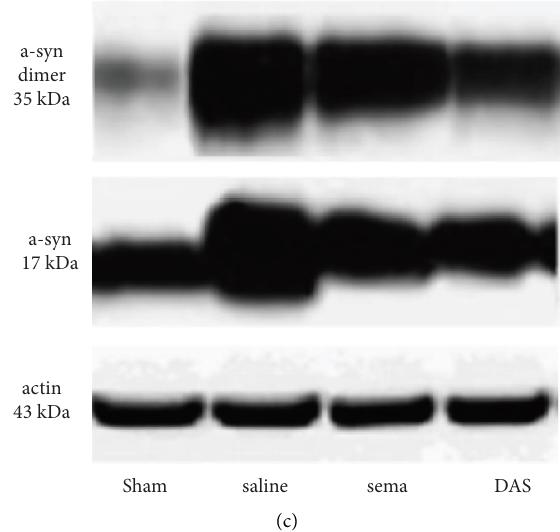
Figure 5: Efects of drugs on 6-OHDA-induced changes in α -synuclein expression in the substantia nigra. (a) Analysis of α -syn monomers (b) and oligomers expression in SNpc . Each group represents the means ± SEM of 5 rats per group; (one-way ANOVA followed by the Tukey multiple comparisons test ; ∗ � p < 0 . 05 ; ∗∗ � p < 0 . 01 ; ∗∗∗∗ � p < 0 . 0001 ; ∗∗∗ � p < 0 . 001 . Te legend relates to both (a) and (b) graphs. (c) Sample western blot. Sham-Sal;6-OHDA+Sal;6-OHDA +Sema; 6-OHDA+ DA5-CH.